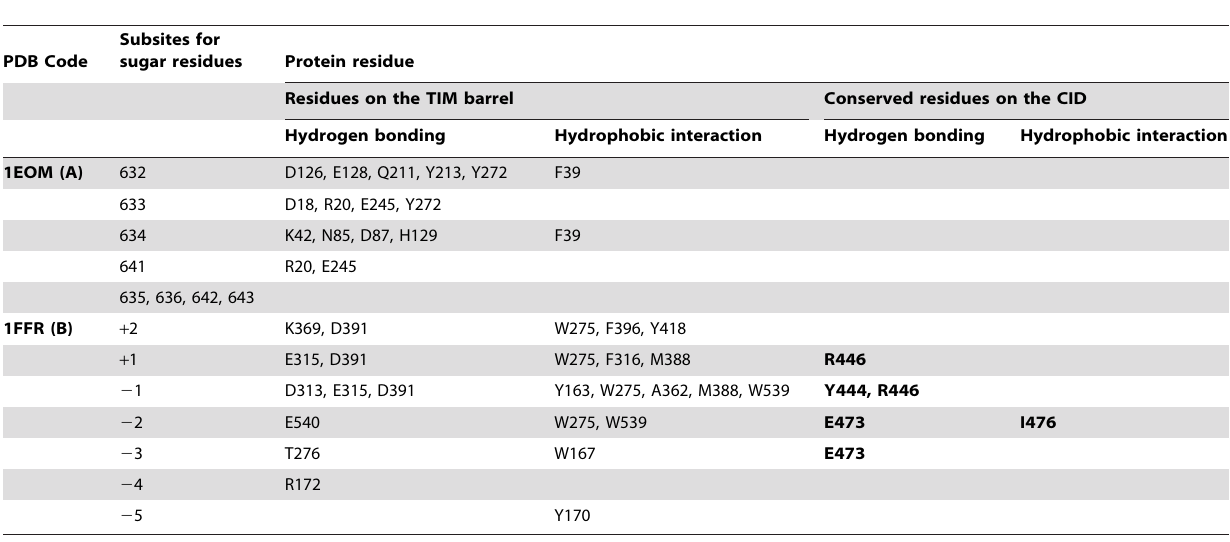
Table 2. Comparison of substrate-binding residues between chitinases with the CID and without the CID.